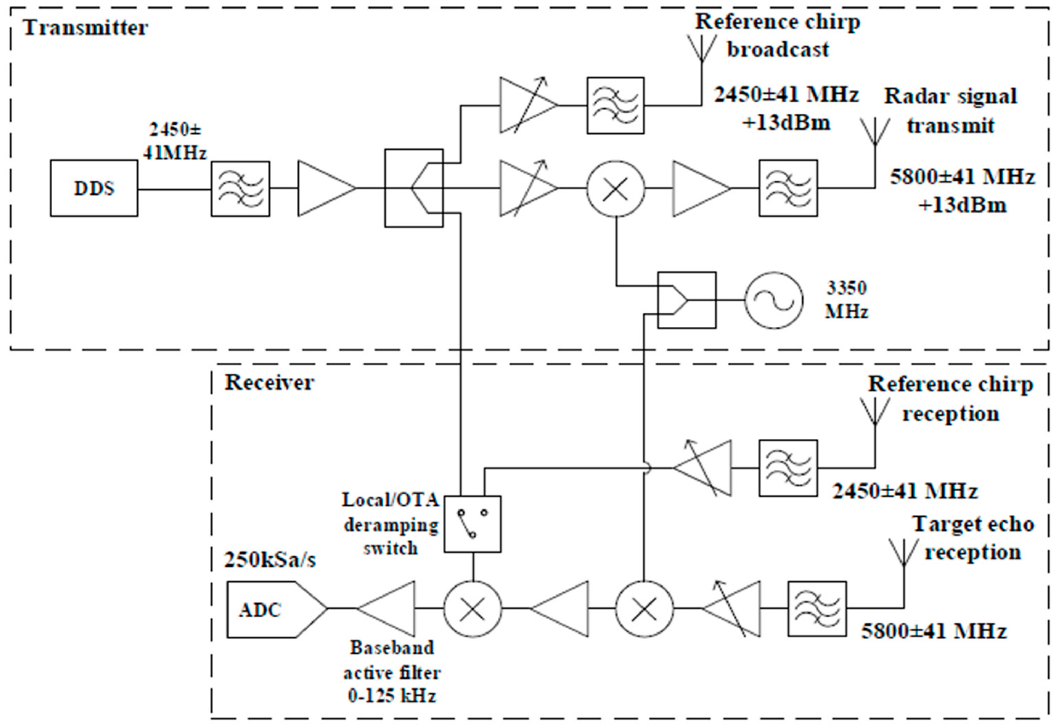
Figure 1. Soprano radar block design. Table 1. Soprano radar